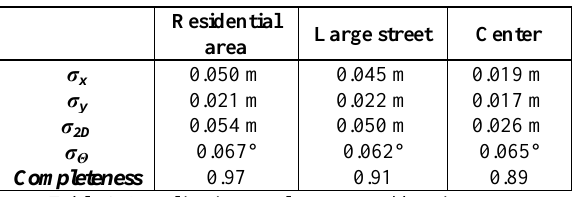
Table 3: Localization results separated by city areas.